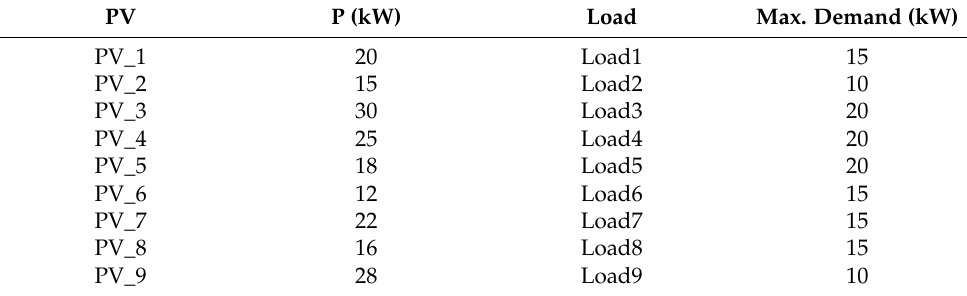
Figure 3. The flowchart of the proposed voltage regulation method. Table 1. PV and load capacity